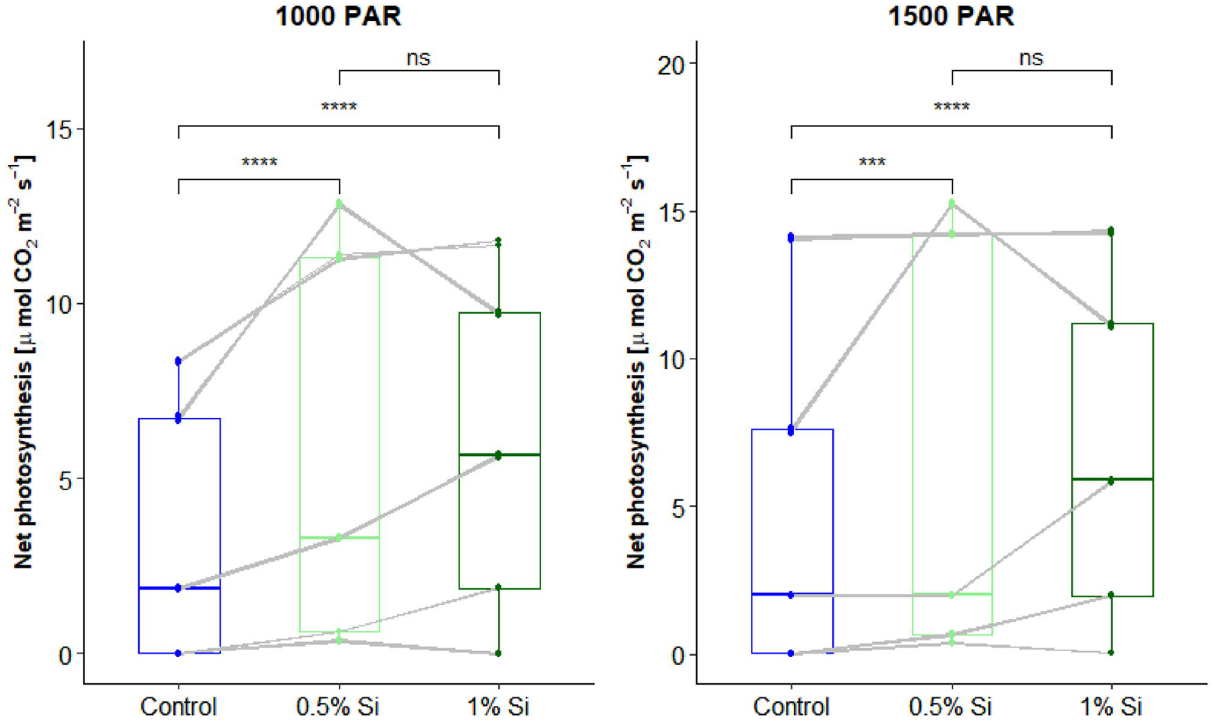
Figure 4. Measured leaf level net photosynthesis for the different treatments (control, 0.5% ASi and 1% ASi) at different light intensity levels. Significance level **** equals p < 0.001. Lines show data pairs each from one measurement date.